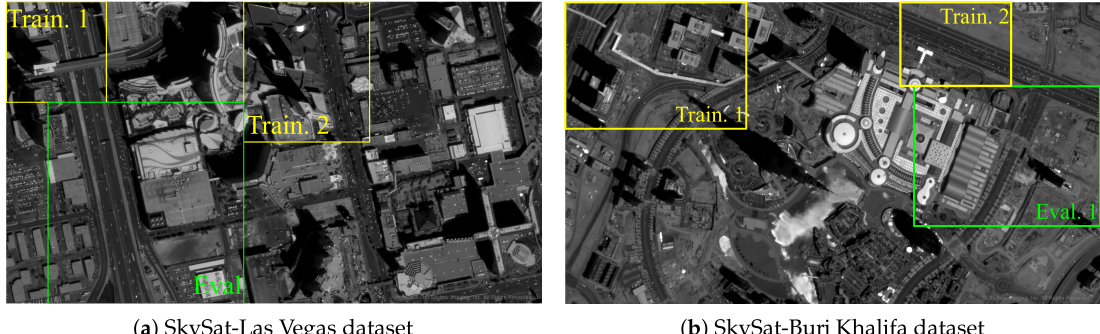
Figure 4. Two typical frames from the two satellite video datasets used. (The regions surrounded by the rectangle in yellow color are for training, while the regions in green color are for